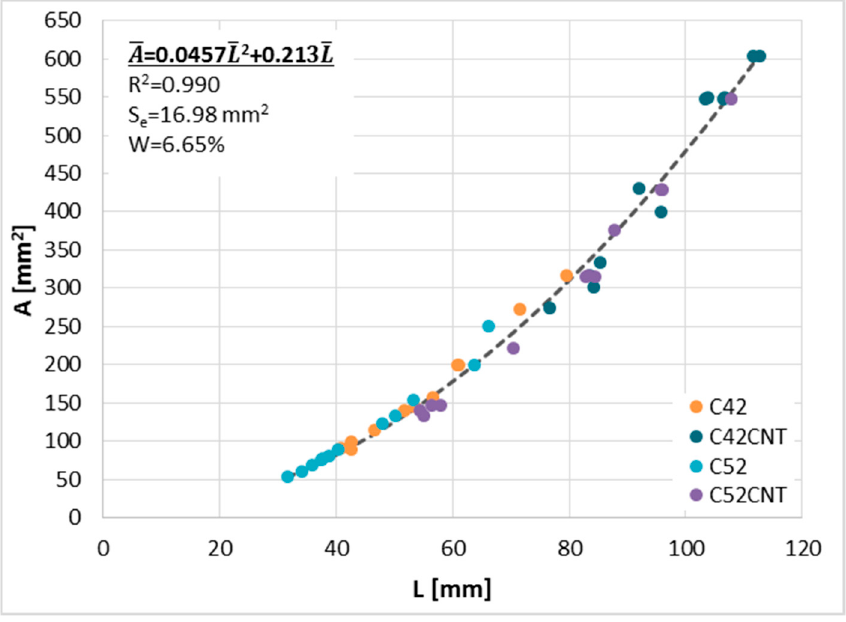
(cid:16) (cid:17) L